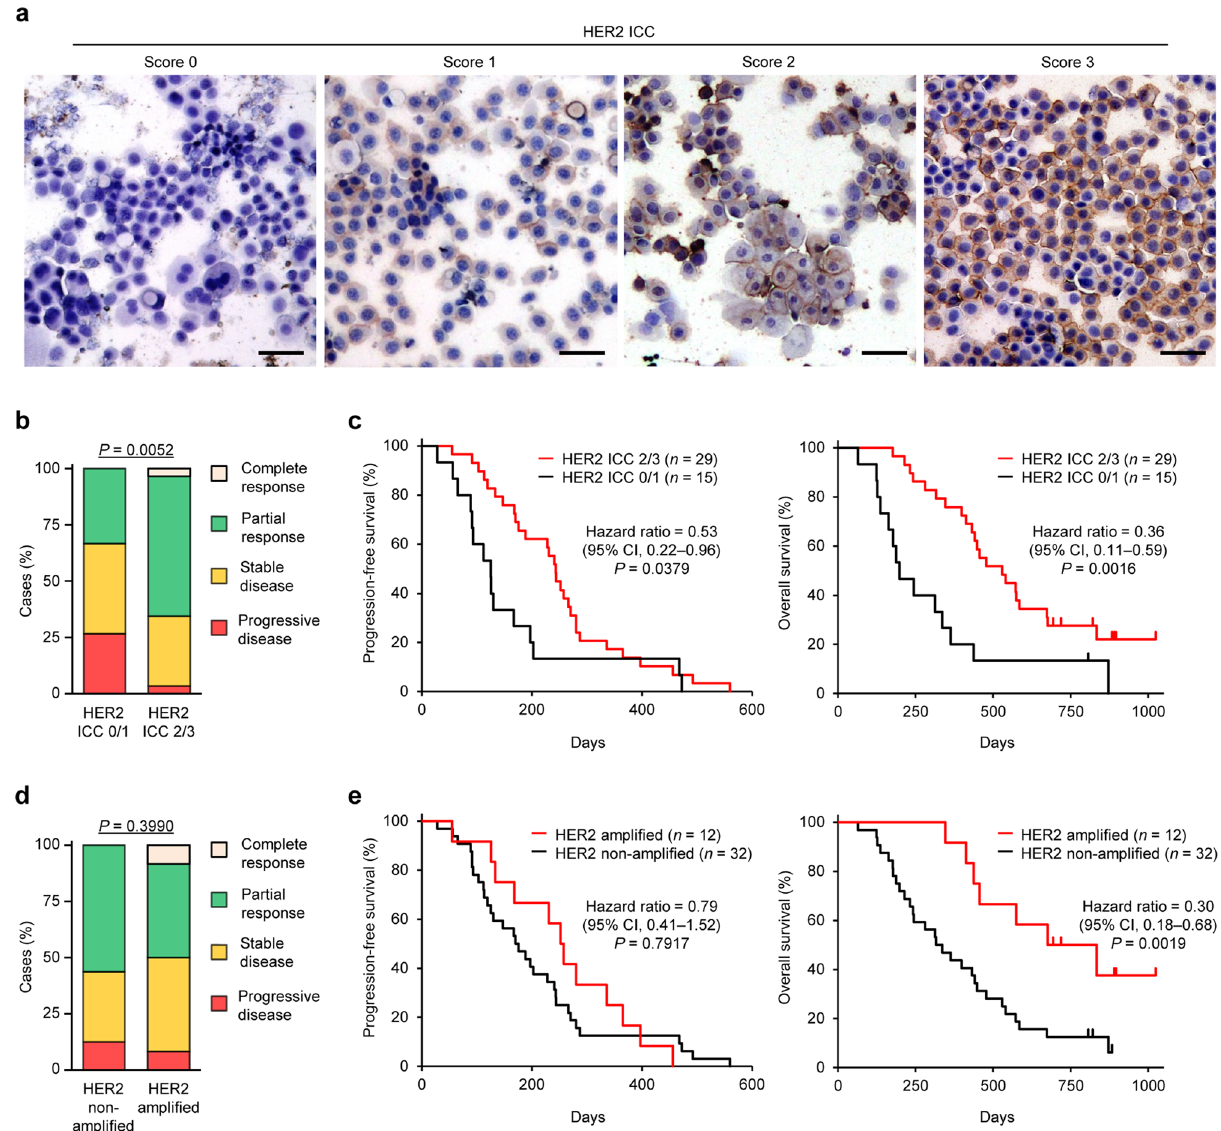
Figure 2. Human epidermal growth factor receptor-2 (HER2) status is associated with the clinical responses and outcomes of lapatinib treatment. ( a ) Representative images of immunocytochemistry (ICC) for HER2 in canine urothelial carcinoma. A score of 0 denotes no reactivity, a score of 1 represents incomplete and weak immunoreactivity in < 10% of tumor cells, a score of 2 represents incomplete but intense immunoreactivity in < 10% of tumor cells, and a score of 3 represents intense with complete immunoreactivity in ≥ 10% of tumor cells. Samples with HER2 ICC scores of 0 and 1 were classified as negative, and those with scores of 2 and 3 as positive. Scale bars, 50 μm. ( b ) Association of HER2 overexpression with response to treatment in dogs treated with lapatinib and piroxicam ( n = 44). Cases were classified as either HER2 positive (ICC 2/3; n = 29) or HER2 negative (ICC 0/1; n = 15). Cochran–Armitage test. ( c ) Kaplan–Meier curves of progression-free survival (left) and overall survival (right) according to HER2 overexpression in dogs treated with lapatinib and piroxicam ( n = 44). Log-rank test and Cox proportional hazard model. ( d ) Association of HER2 gene amplification with response to treatment in dogs treated with lapatinib and piroxicam ( n = 44). Cases were classified as HER2 amplified ( n = 12) or HER2 non-amplified ( n = 32). Cochran–Armitage test. ( e ) Kaplan–Meier curves of progression-free survival (left) and overall survival (right) according to HER2 gene amplification in dogs treated with lapatinib and piroxicam ( n = 44). Log-rank test and Cox proportional hazard